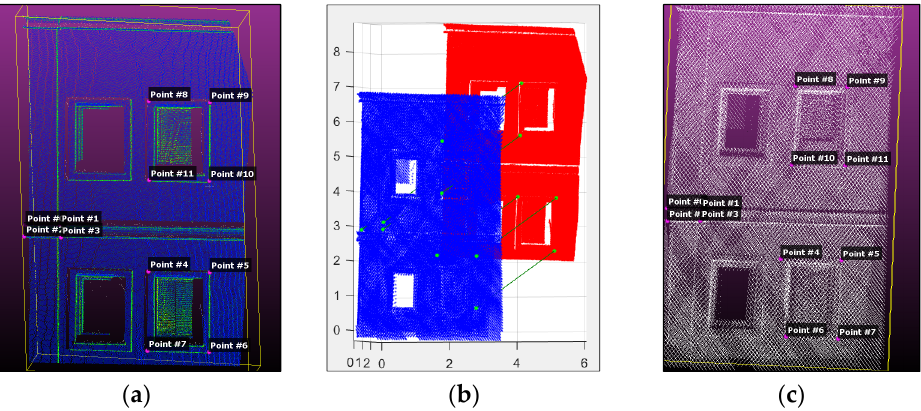
Figure 17. Aristotle sculpture: ( a ) the keypoints identified by LSP in the 1st point cloud; ( b ) matching two-point clouds with LSP+PFH algorithm; ( c ) the keypoints identified by LSP in the 2nd point cloud.